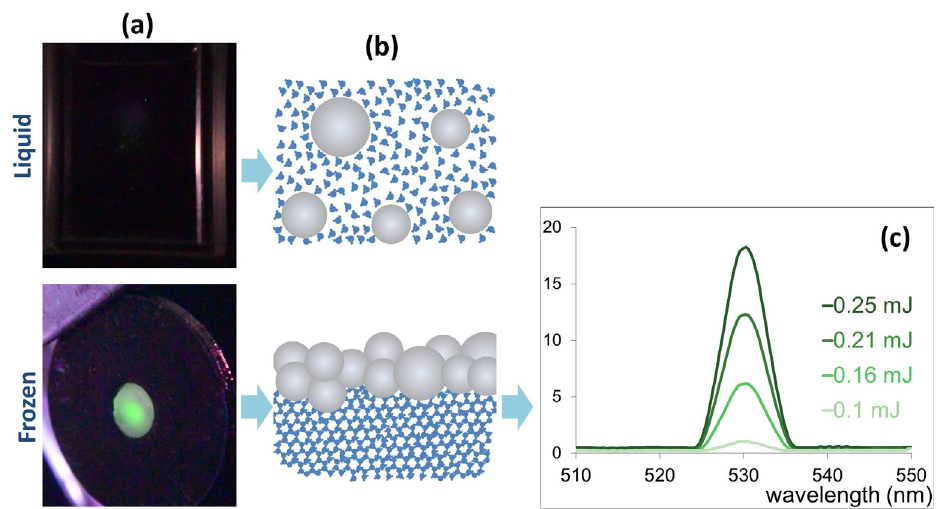
Figure 2. ( a ) Photo of liquid and frozen suspension with second-harmonic signal; ( b ) schematic rep- resentation of the arrangement of particles in liquid and frozen suspensions; ( c ) SHG spectrum in a frozen suspension at different pump energies.